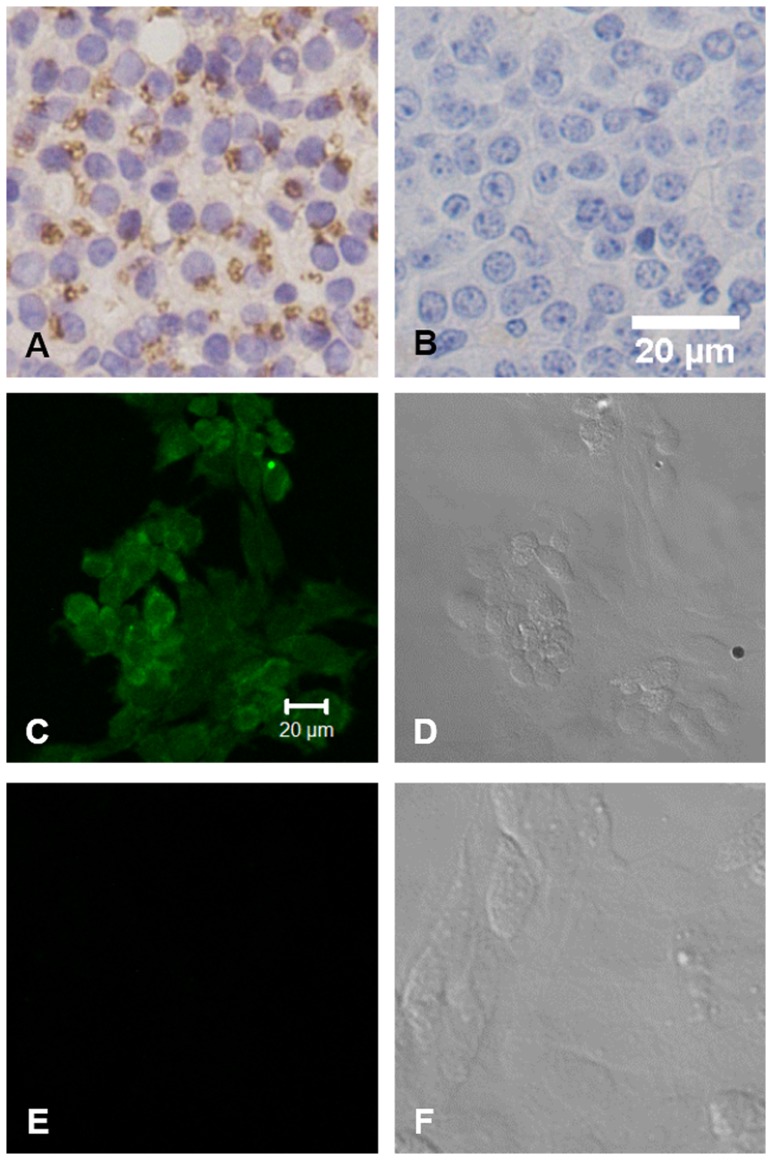
Detection of inhibin α-subunit expression in the mouse anterior pituitary.A: Inhibin α-subunit expression in the mouse anterior pituitary gland using immunohistochemical methods. Immunohistochemical analysis of inhibin α subunit expression in the anterior pituitary gland by inhibin monoclonal antibody [A1] and PBS [A2], magnification is ×40. B: Inhibin α subunit expression in the cultured mouse anterior pituitary cells using indirect immunofluorescence. Indirect immunofluorescence analysis of inhibin α subunit expression in the anterior pituitary cells by inhibin monoclonal antibody [B1] and PBS [B2], magnification is ×40.